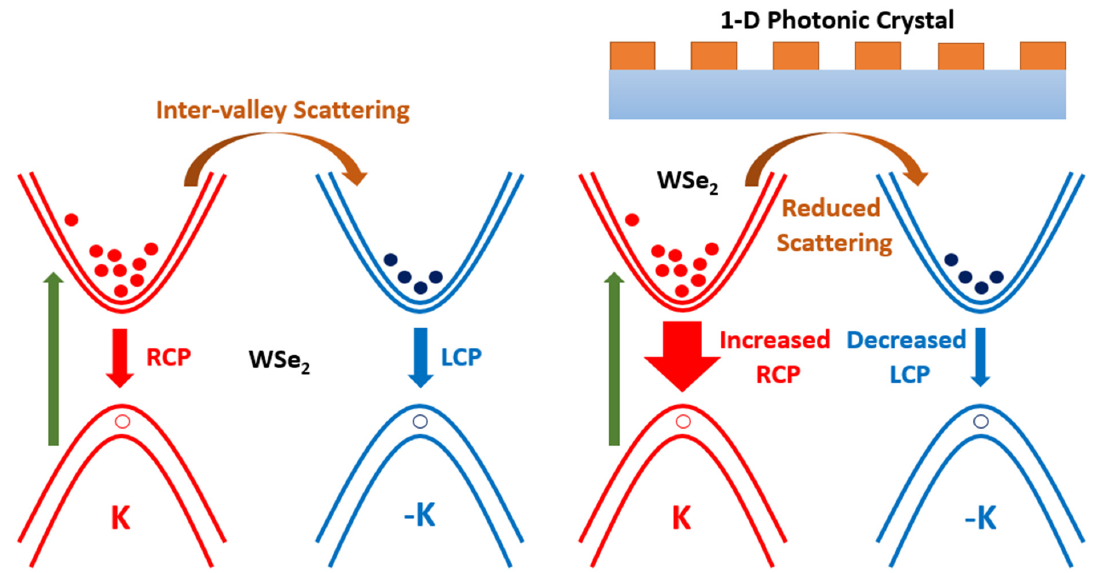
Figure 8. Mechanism for monitoring valley polarization in WSe 2 /1-D PhC integrated system. Under RCP light excitation, the WSe 2 /1-D PhC integrated system shows a significantly higher decay rate for excitons in K valley, while reduced decay rates for excitons in –K valley.